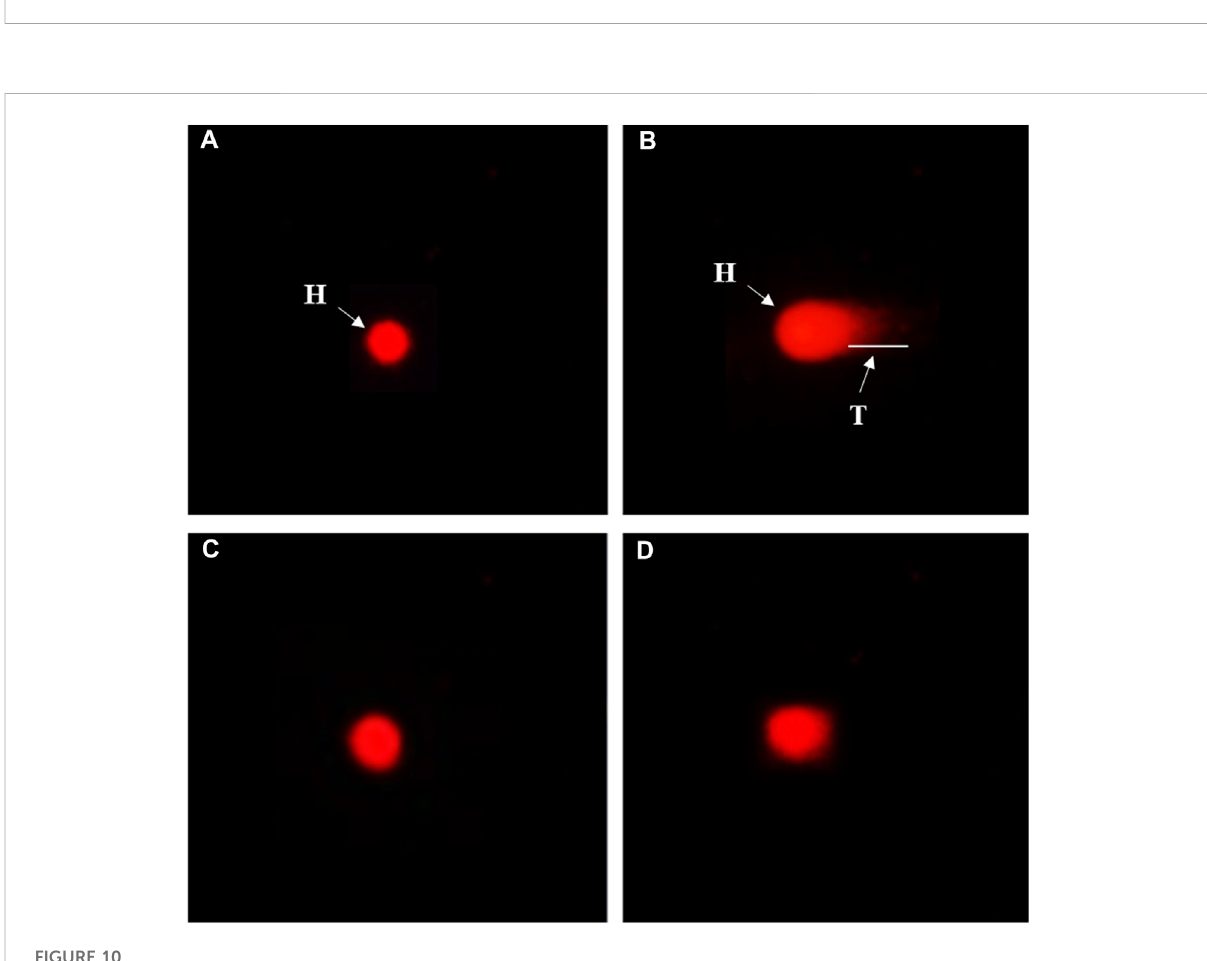
FIGURE 10 Genotoxicity evaluation of CDPDP on blood lymphocytes. Note: ( A ) The vehicle control (1% DMSO) ( B ) Ethyl methane sulfonate (20 μ g/ml) ( C ) CDPDP (10 μ g/ml) ( D ) CDPDP (20 μ